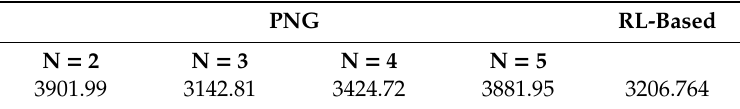
Table 3. Energy consumption comparison under ideal